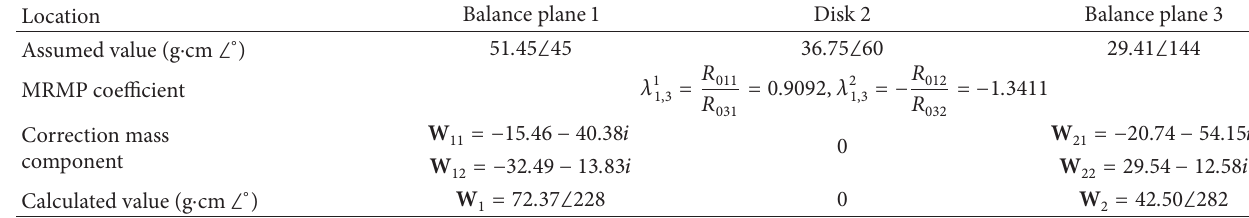
Table 4: Unbalance correction for the first two critical speeds.